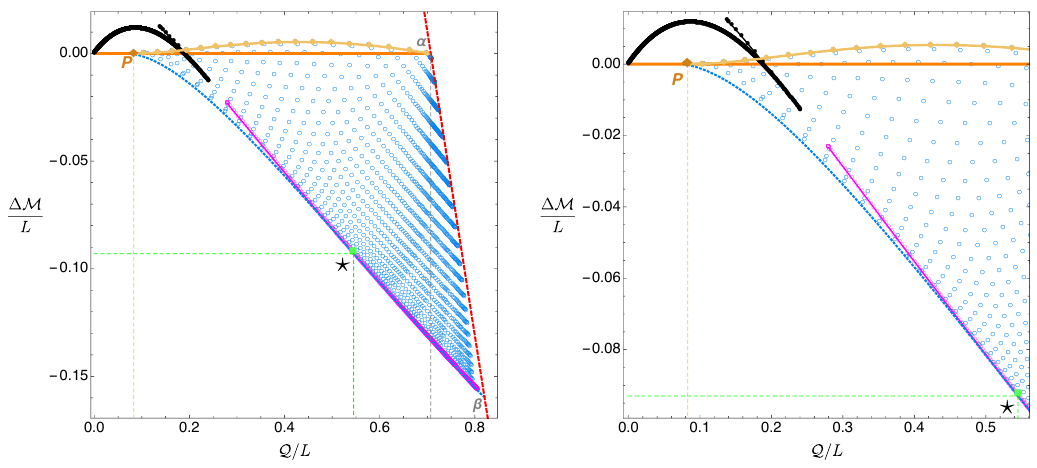
Figure 4 . Phase diagram for Einstein theory with a scalar field charge e = 1 . 85 ( e γ ≤ e < e c ) in a Minkowski box. The blue circles describe hairy black holes, the black disk (magenta circle) curve is the soliton main (secondary) family, and the orange line is the extremal RN BH (non-extremal RN BHs exist above it). The yellow curve is the superradiant onset curve of RN. As it could not be otherwise, it agrees with the hairy solutions in the limit where these have (cid:15) = 0 and thus merge with RN family. The dashed vertical line is at Q = 2 − 1 / 2 which is the maximum local charge that an extremal RN BH can have while fitting inside a box with radius R = 1 . The red dashed line (4.1) describes the boundary for black holes that can fit inside the cavity with radius R = 1 . The green solid square labelled with a star ( ? ) has ( Q ∆ M ) ∼ (0 . 545 , 0 . 678 , − 0 . 093) . The ? , M ? , ? auxiliary blue dotted curve P ? β in the bottom describes the line where hairy BHs terminate with unbounded horizon curvature. Hairy BHs that terminate in the trench P? of this auxiliary curve do so at finite entropy and vanishing temperature. On the other hand, hairy BHs that terminate in the trench segment ?β (that coincides with magenta soliton line) do so at zero entropy and large (possibly infinite) temperature.